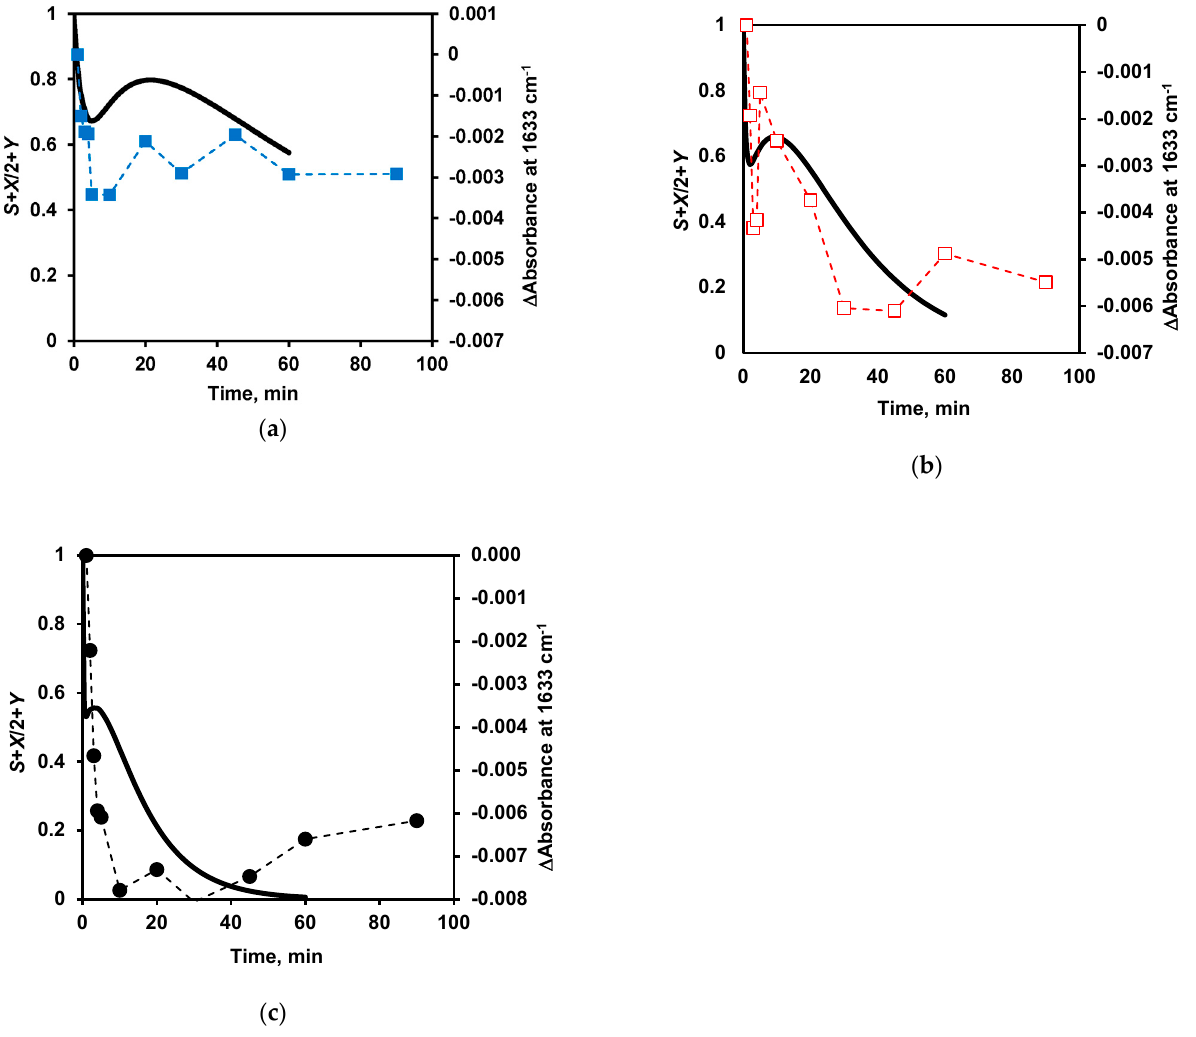
Figure 11. Comparison of the changes in secondary structures in the course of proteolysis according to the model (solid line) at S 0 / E 0 ratios of 1000 ( a ), 250 ( b ), and 63 ( c ), and FTIR data (dotted line) at S 0 / E 0 ratios of 10,000 ( a , ■ , blue), 4000 ( b , □ , red), and 500 ( c , ● , black).